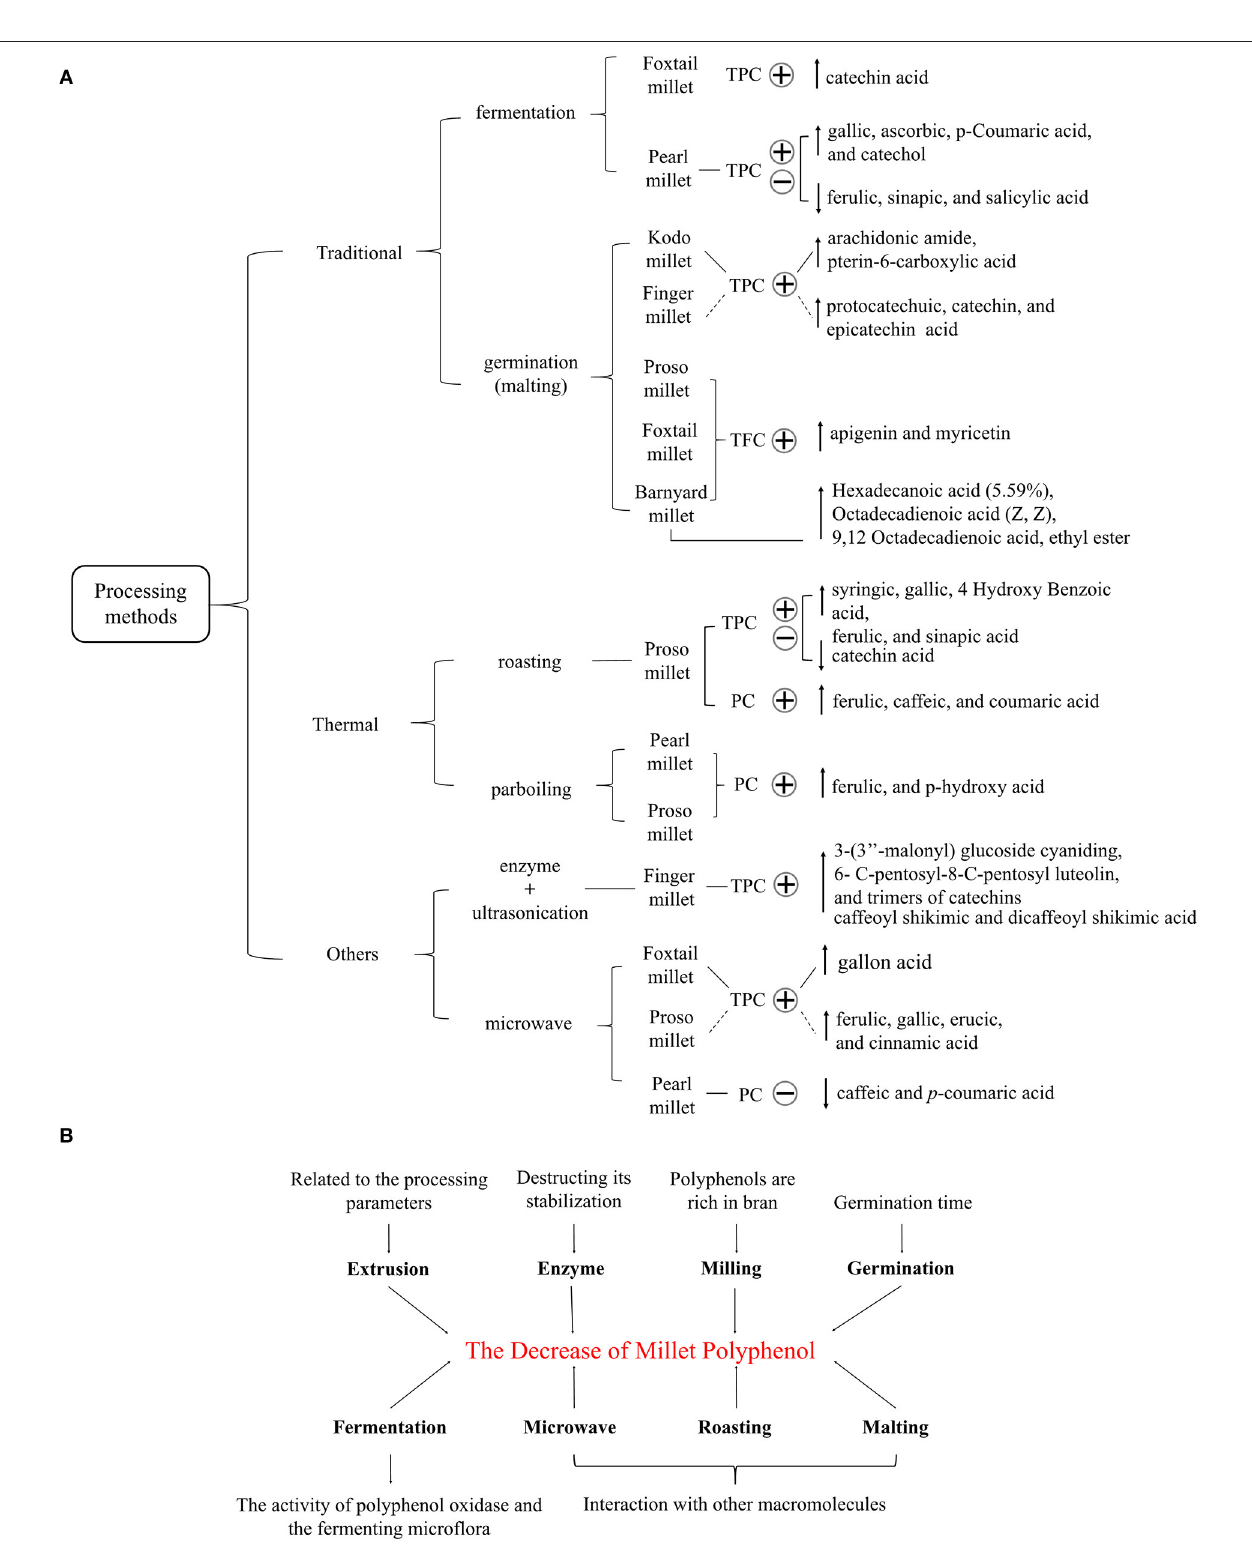
FIGURE 2 | (A) The influence of different processing methods on the content of certain polyphenols (PC) and total polyphenols (TPC) in millet. The plus and minus signs represent increase and decrease, respectively. (B) The factors related to the decrease of millet polyphenols.